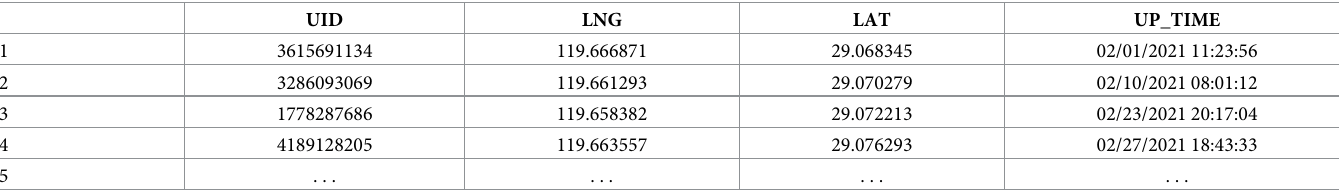
Table 3. The travel data structure of urban public transport in Jinhua